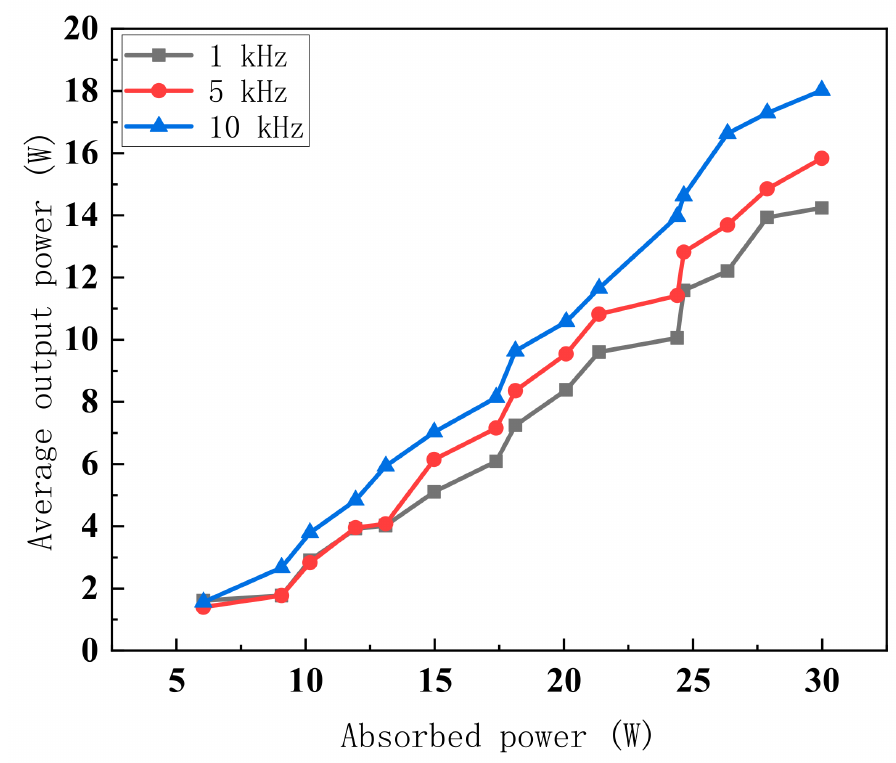
Figure 5. Average output power of Q-switched Ho:YAP laser versus absorbed power.